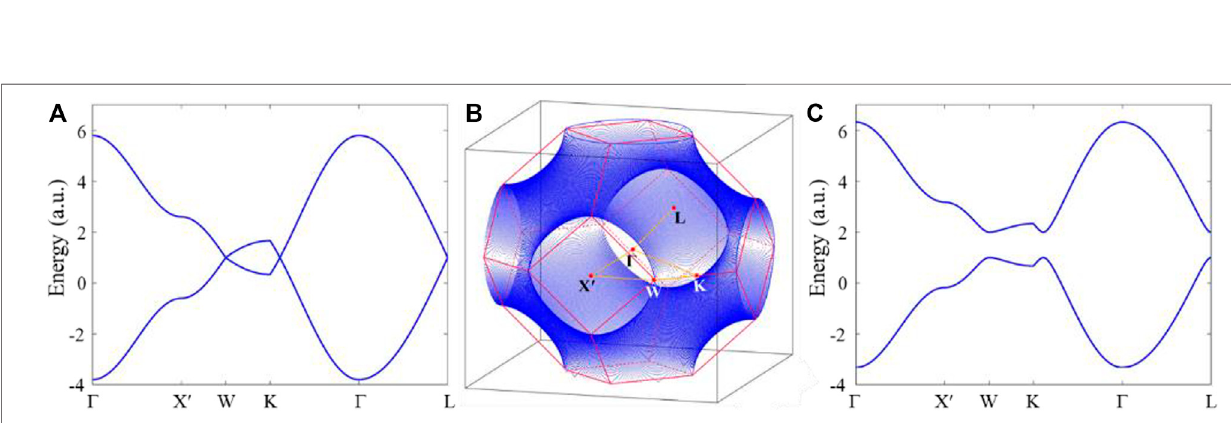
Frontiers in Physics |